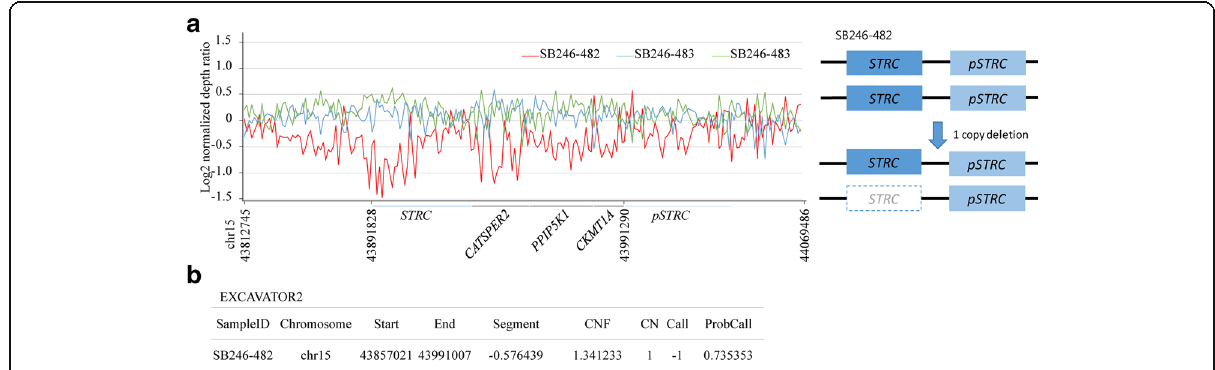
Fig. 5 Copy number variant identification by in-house CNV tool and EXCAVATOR2 with WES. a The horizontal axis indicates chromosomal position, and the vertical axis indicates the log2 normalized depth ratio; 0 indicates 2 copies and − 1.0 indicates 1 copy deletion, respectively. The red line indicates SB246 – 482, light-blue line indicates SB246 – 483, and green line indicates SB246 – 484, respectively. A heterozygote deletion in the STRC and CATSPER2 region is seen in only SB246 – 482. The hypothesized mechanisms for the event is shown to the right. b The result of EXCAVATOR2 also indicates 1 copy deletion in the region where STRC and CATSPER2 as well as PPIP5K1 and CKMT1A were located